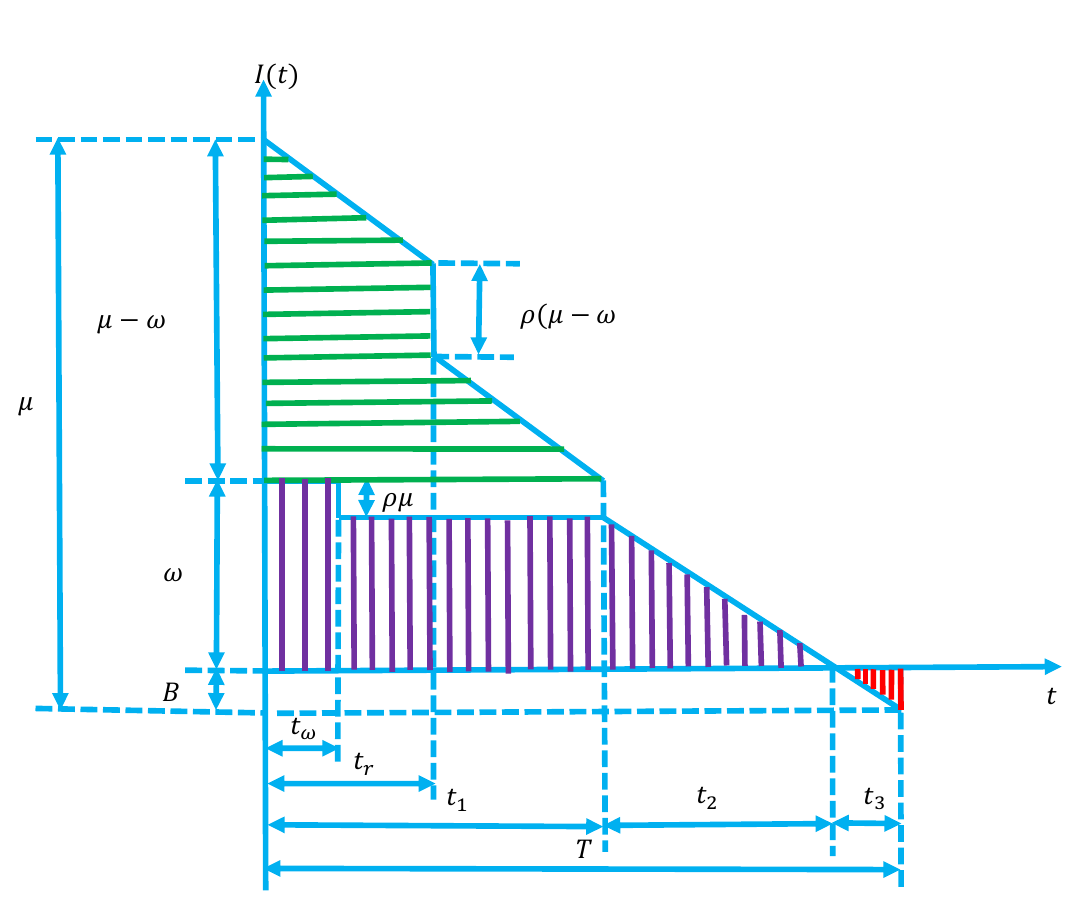
Figure 1. The inventory level of items in stock of two warehouse if 𝑡